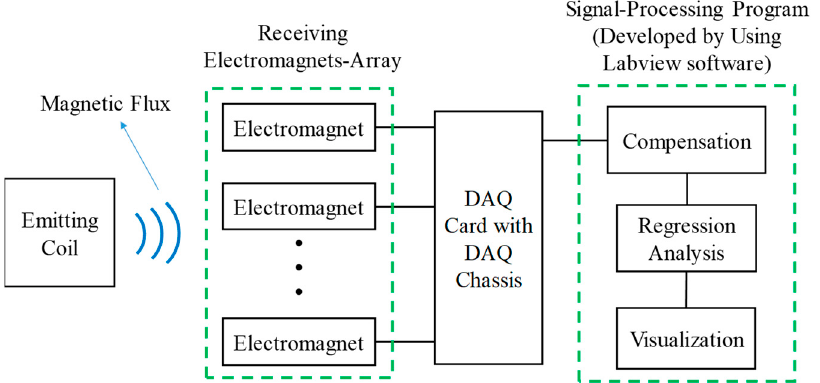
Figure 3. The architecture of the system.